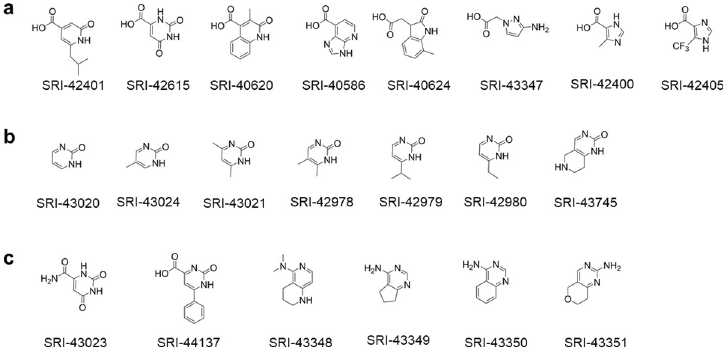
Fig 5. Fragments that failed to co-crystalize with nsP3MD. Shown are compounds that contain: a) a carboxylic acid group and other ring structures; b) a pyrimidone ring without carboxylic acid; and c) similar ring structures to the pyrimidone ring and with different chemical group substitutions on the ring